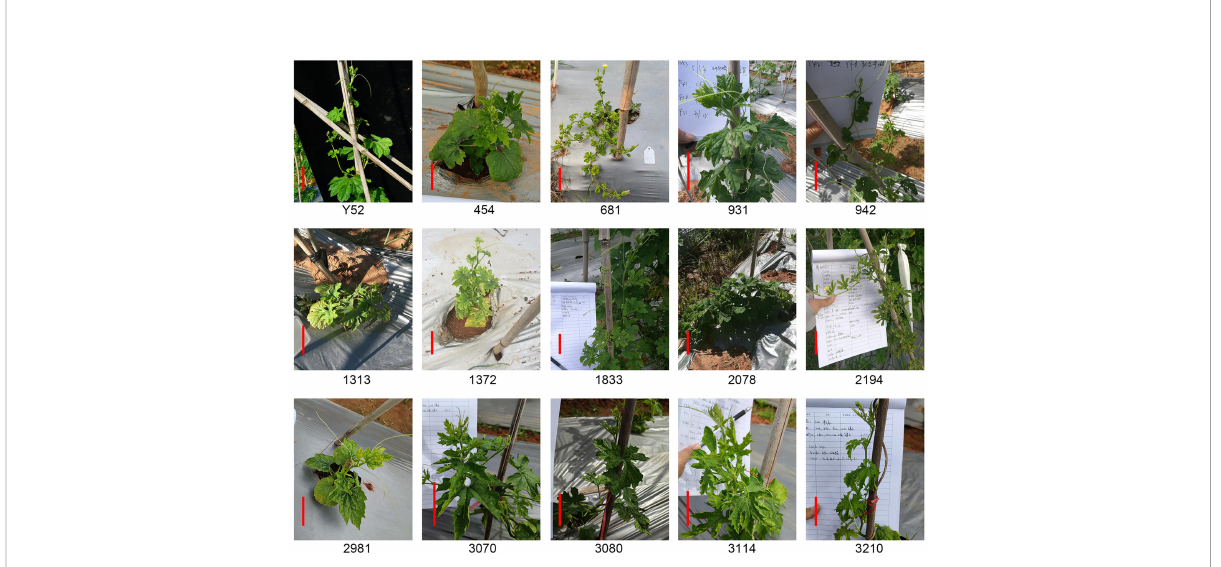
FIGURE 1 Different dwarf mutants in the M 2 generation compared to Y52. Scale bar in red color = 5